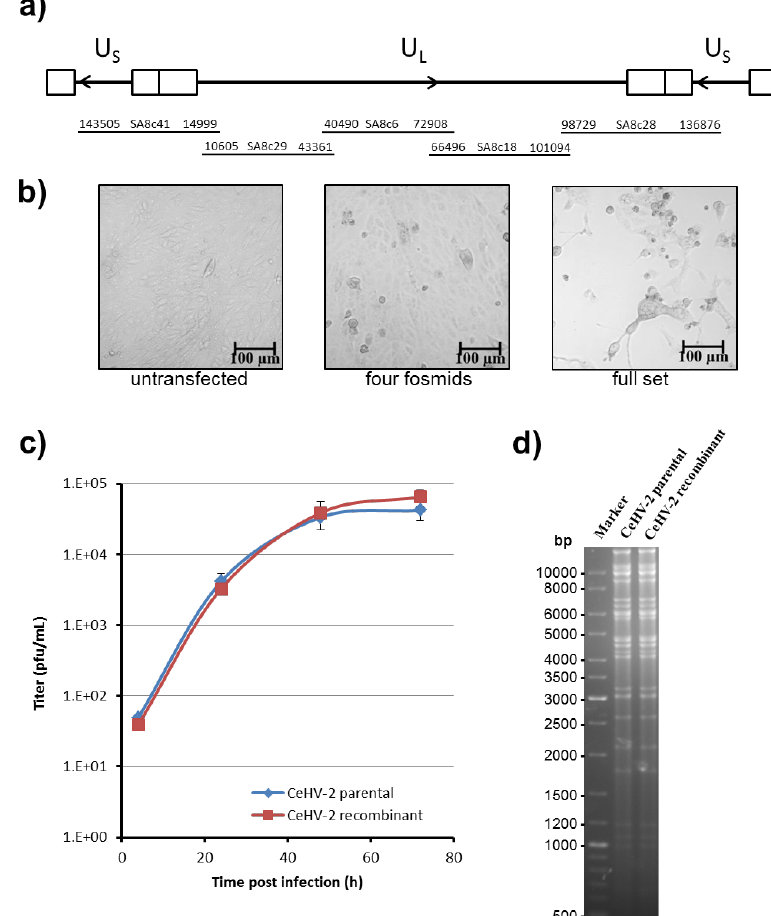
Figure 2. Rescue and characterization of recombinant CeHV-2 virus. ( a ) Schematic depiction of the CeHV-2 genome as in Figure 1b along with the fosmid clones used for rescue. ( b ) Cells were transfected with a linearized set of the fosmids. Brightfield images of untransfected Vero76 cells (left panel) and Vero76 cells transfected with a partial (four fosmids; fosmid SA8c6 missing; middle panel) and a full set (right panel) taken 3 days after transfection are shown below. Scale bars represent 100 µ m. ( c ) Replication kinetics of parental and recombinant CeHV-2 viruses on Vero76 cells infected with MOI 1. Culture supernatant was harvested at the indicated time points and virus titer determined by plaque assay. The results of a representative experiment, carried out with triplicate samples, are shown. Similar results were obtained in a separate experiment. Error bars indicate standard deviation (SD). ( d ) Restriction digest with BamHI of genomes of parental and recombinant CeHV-2 viruses isolated from virus particles.